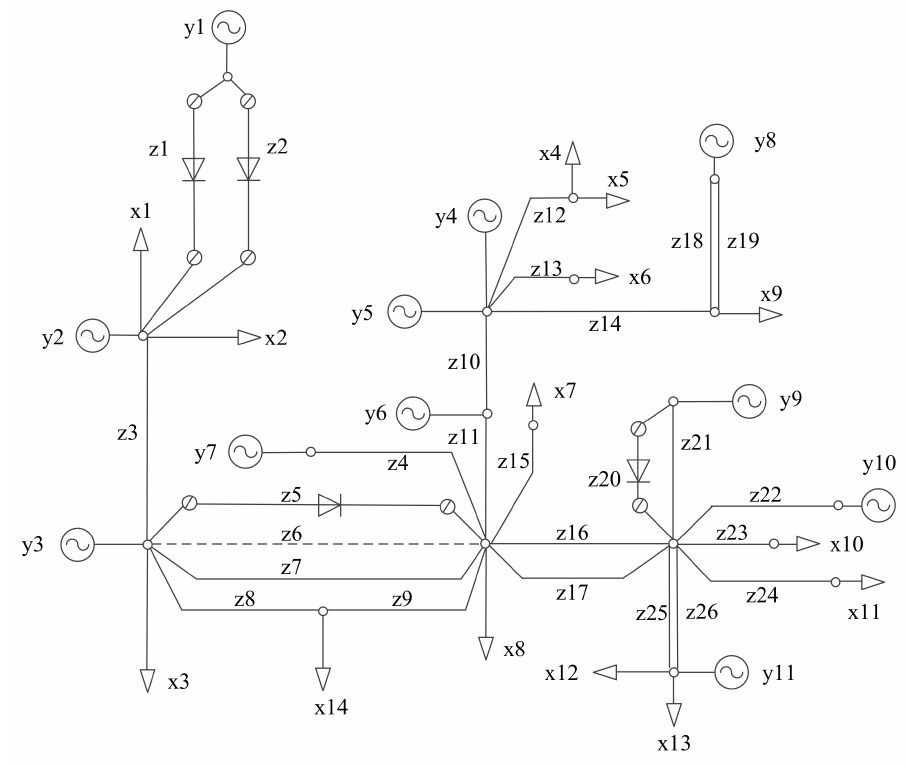
Figure 7. Regional power system in eastern